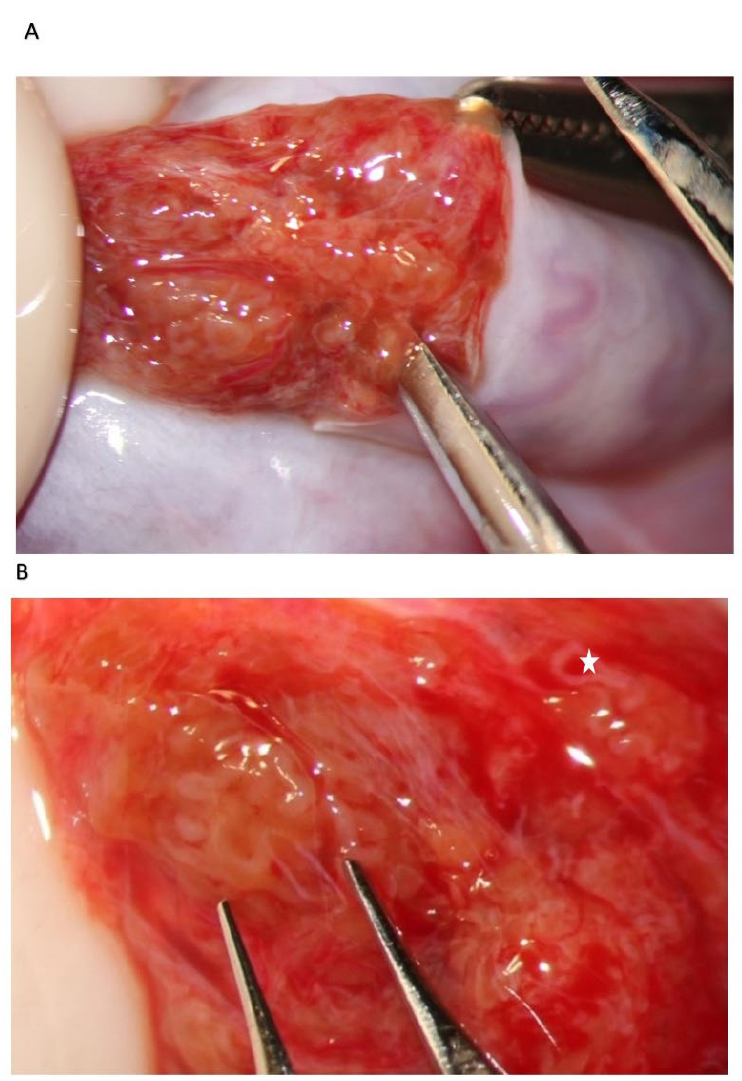
Figure 13. Testis in a patient with Klinefelter syndrome. ( A ) low magnification; ( B ) high magnification ( × 36): forceps tips indicate a tiny group of dilated tubules inside a brownish area rich with Leydig cells, with atrophic tubules in the background (one atrophic tubule is marked with a star).